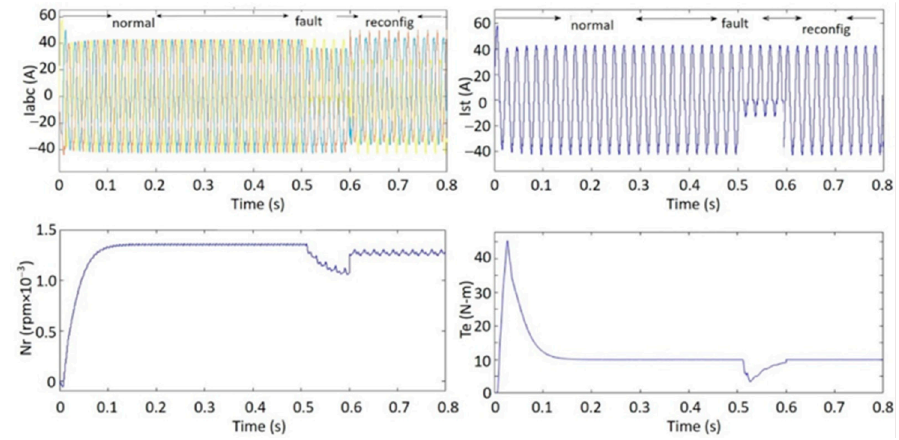
Figure 8. Simulation results during a GOC fault and the fault reconfiguration technique.